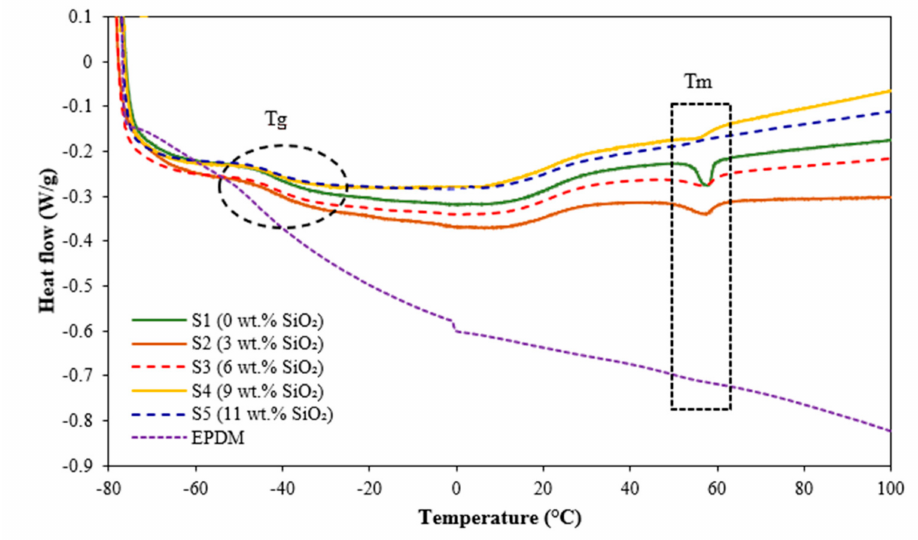
Figure 5. DSC curves of neat EPDM and EPDM-based MREs with different contents of